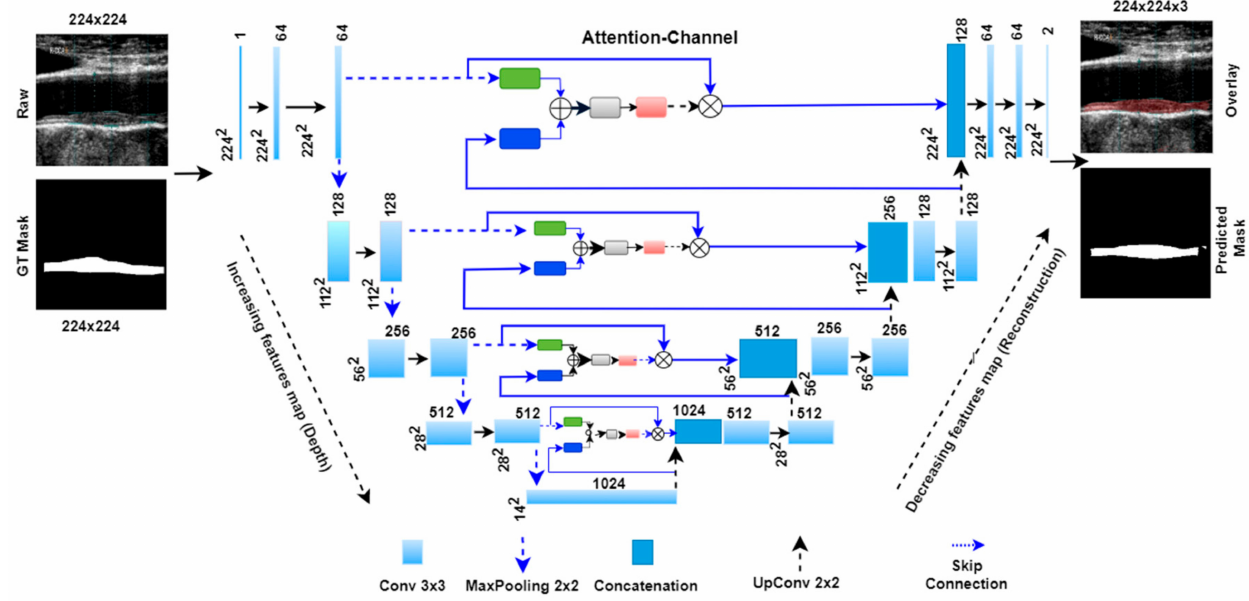
Figure 7. Four-stage Attention-UNet